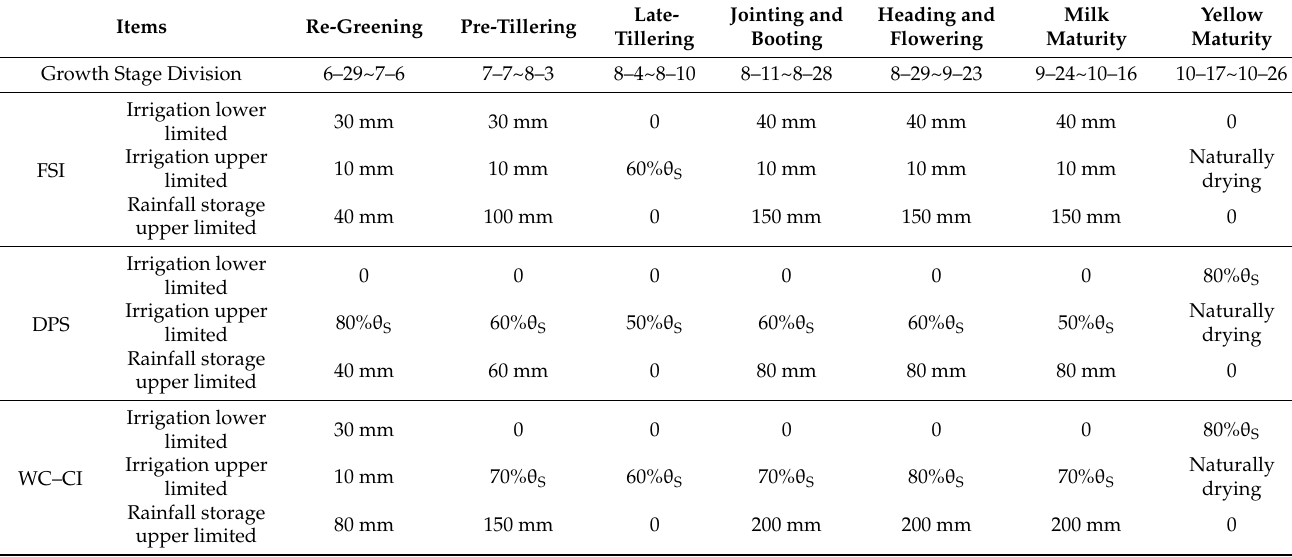
Table 2. The water management table of different irrigation and drainage patterns.